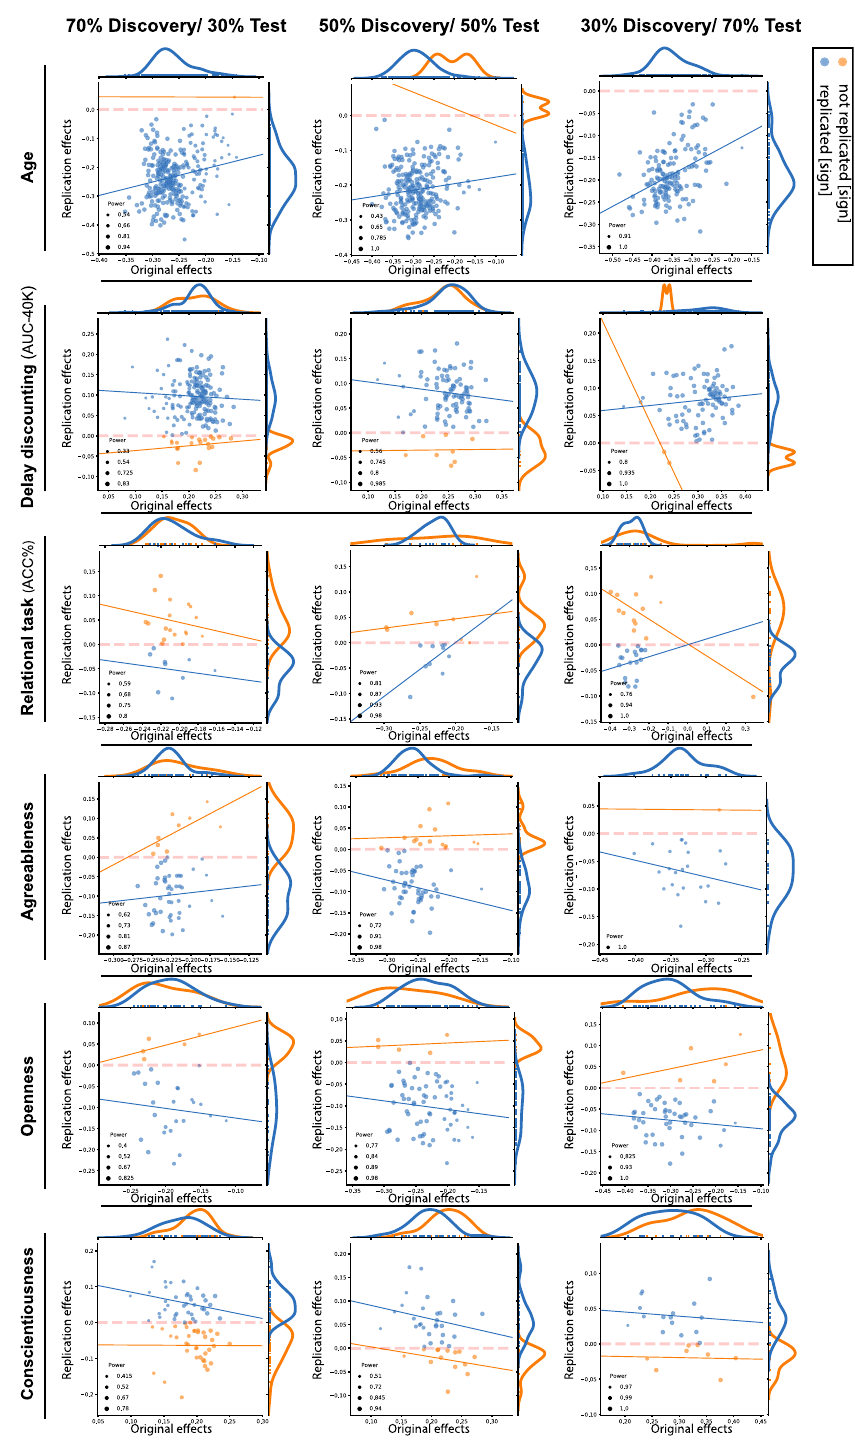
Figure 3. Discovery versus replication effects sizes: Scatter plots of effect sizes in the discovery versus replication sample for all ROIs from 100 splits within healthy cohort; each point denote one ROI, which is color- coded based on its replciation status (by-“sign”). Size of each point is proportional to its estimated statistical power of replication. Regresion lines are drawn for the replciated and unreplicated ROIs,